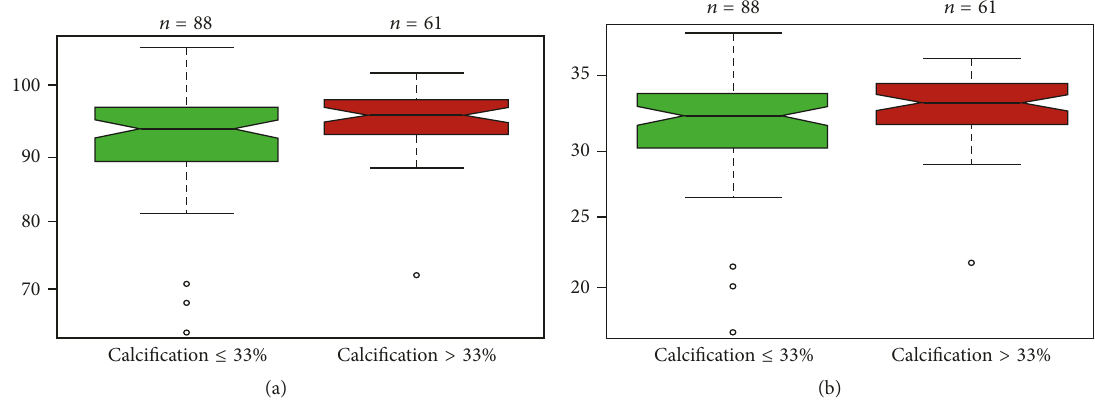
Figure 1: Boxplots for MCV (a) and MCH (b) using grouping variable calcification.